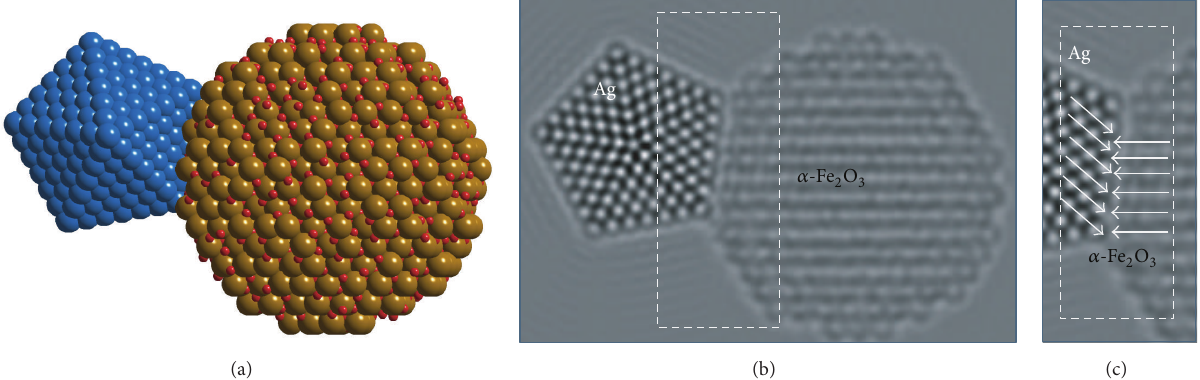
Figure 3: (a) Simulation model of the dumbbell-like 𝛼 -Fe 2 O 3 -Ag nanostructure, (b) simulated bright field image, and (c) simulated image from the interface of 𝛼 -Fe 2 O 3 -Ag.